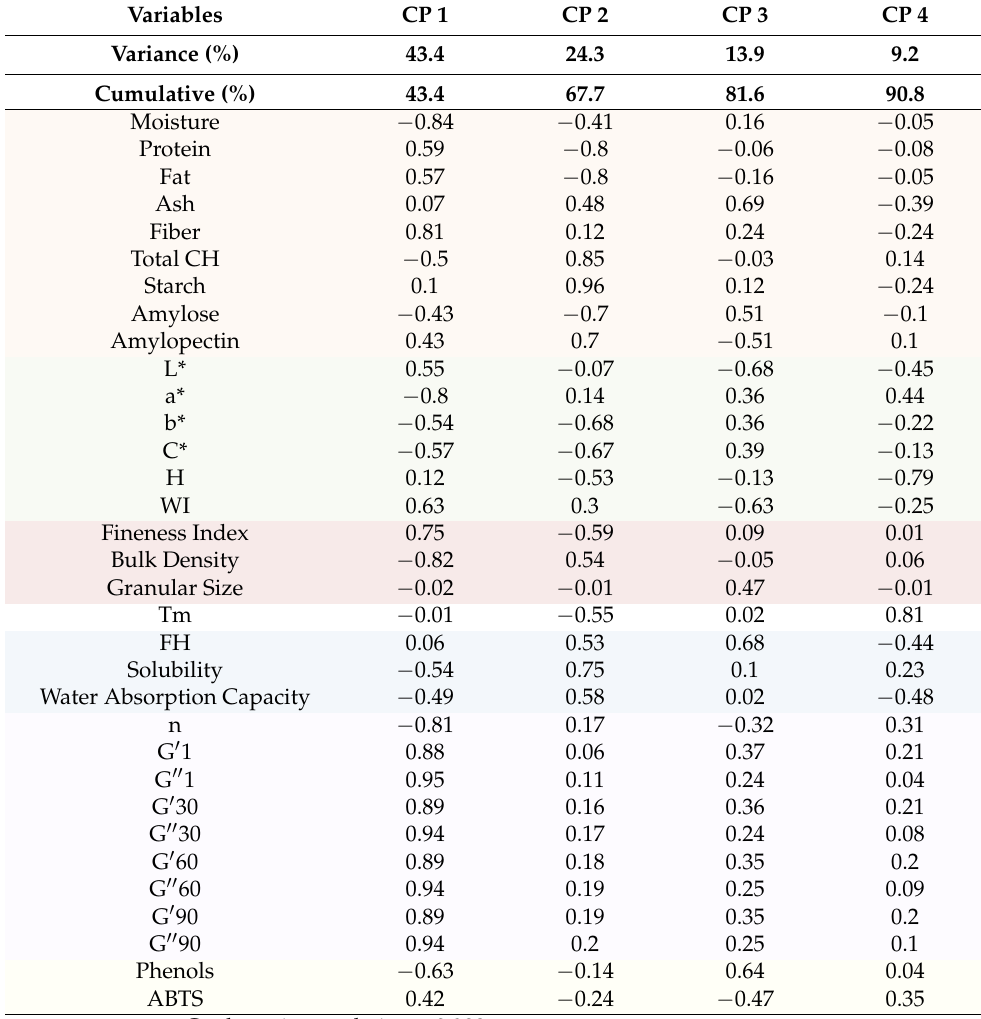
Table 7. Variance, variance cumulative, and factor loading of principal components (PC) for the variables of